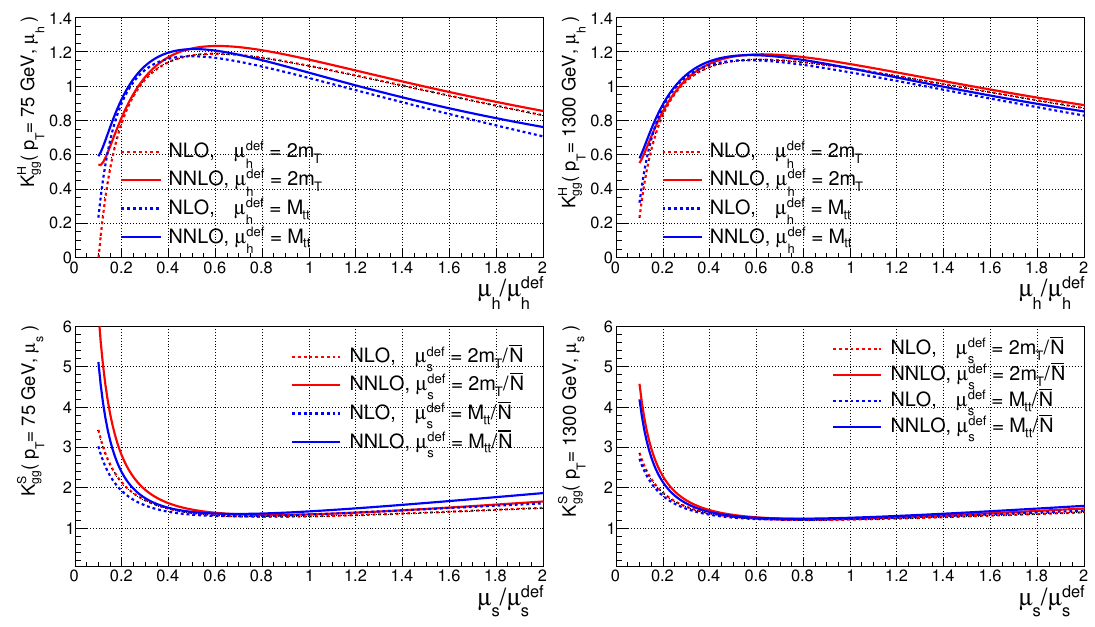
Figure 3 . The K factors for the corrections to the hard (top) and soft (bottom) functions in the gg channel as de(cid:12)ned in the text, at p T = 75 GeV (left) and p T = 1300 GeV